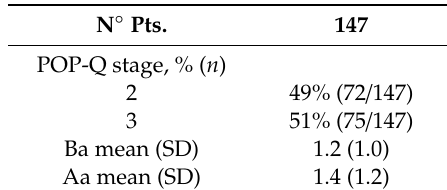
Figure 2. Study design diagram. Table 1. Patients characteristics.